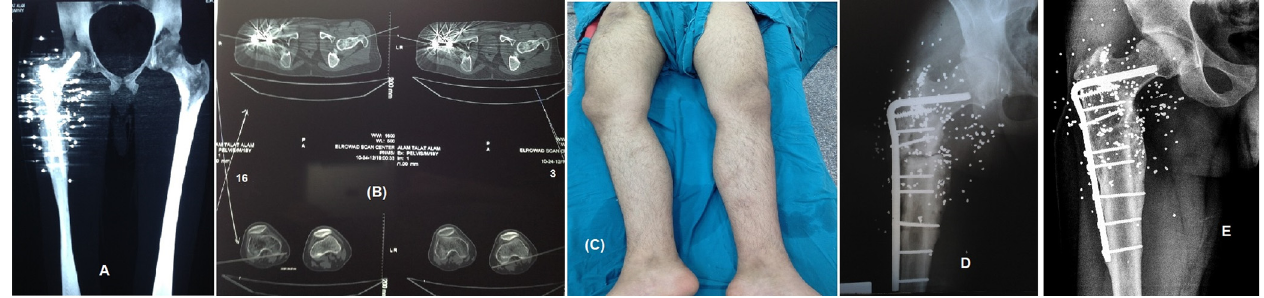
Figure 6. A 22-year old male patient with OGIII-A subtrochanteric femoral fracture due to gunshot injury managed with gamma nail, A) postoperative Scout fi lm, B) postoperative CT scan with 19 degrees external rotation, C) external rotation deformity, D) X-ray after corrective osteotomy, E) 84 months follow